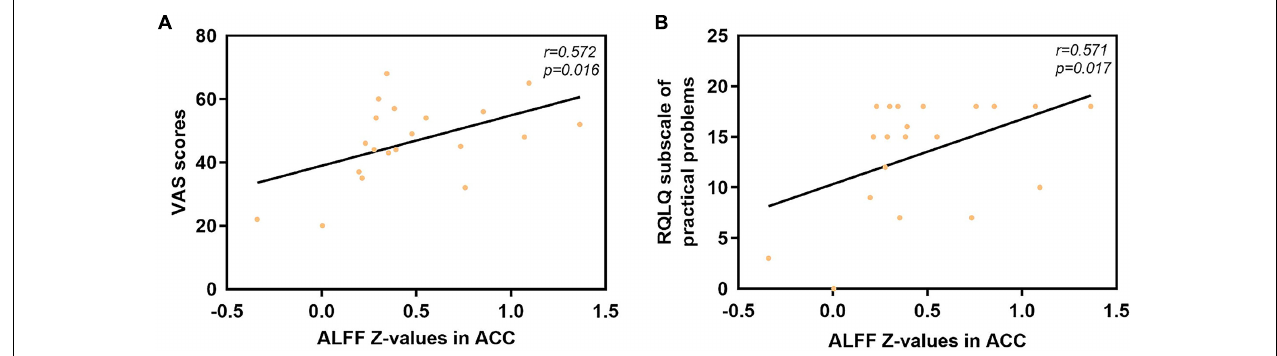
FIGURE 4 | Significant correlation analyses between AR patients’ ALFF values in the ACC and clinical indexes. (A) ACC and VAS scores: n = 20, r = 0.572, p = 0.016. (B) ACC and subscale of practical problems of RQLQ scores: n = 20, r = 0.571, p = 0.017. ALFF, amplitude of low-frequency fluctuation; AR, allergic rhinitis; ACC, anterior cingulate cortex; VAS, visual analog scale; RQLQ, Rhinoconjunctivitis Quality of Life Questionnaire.